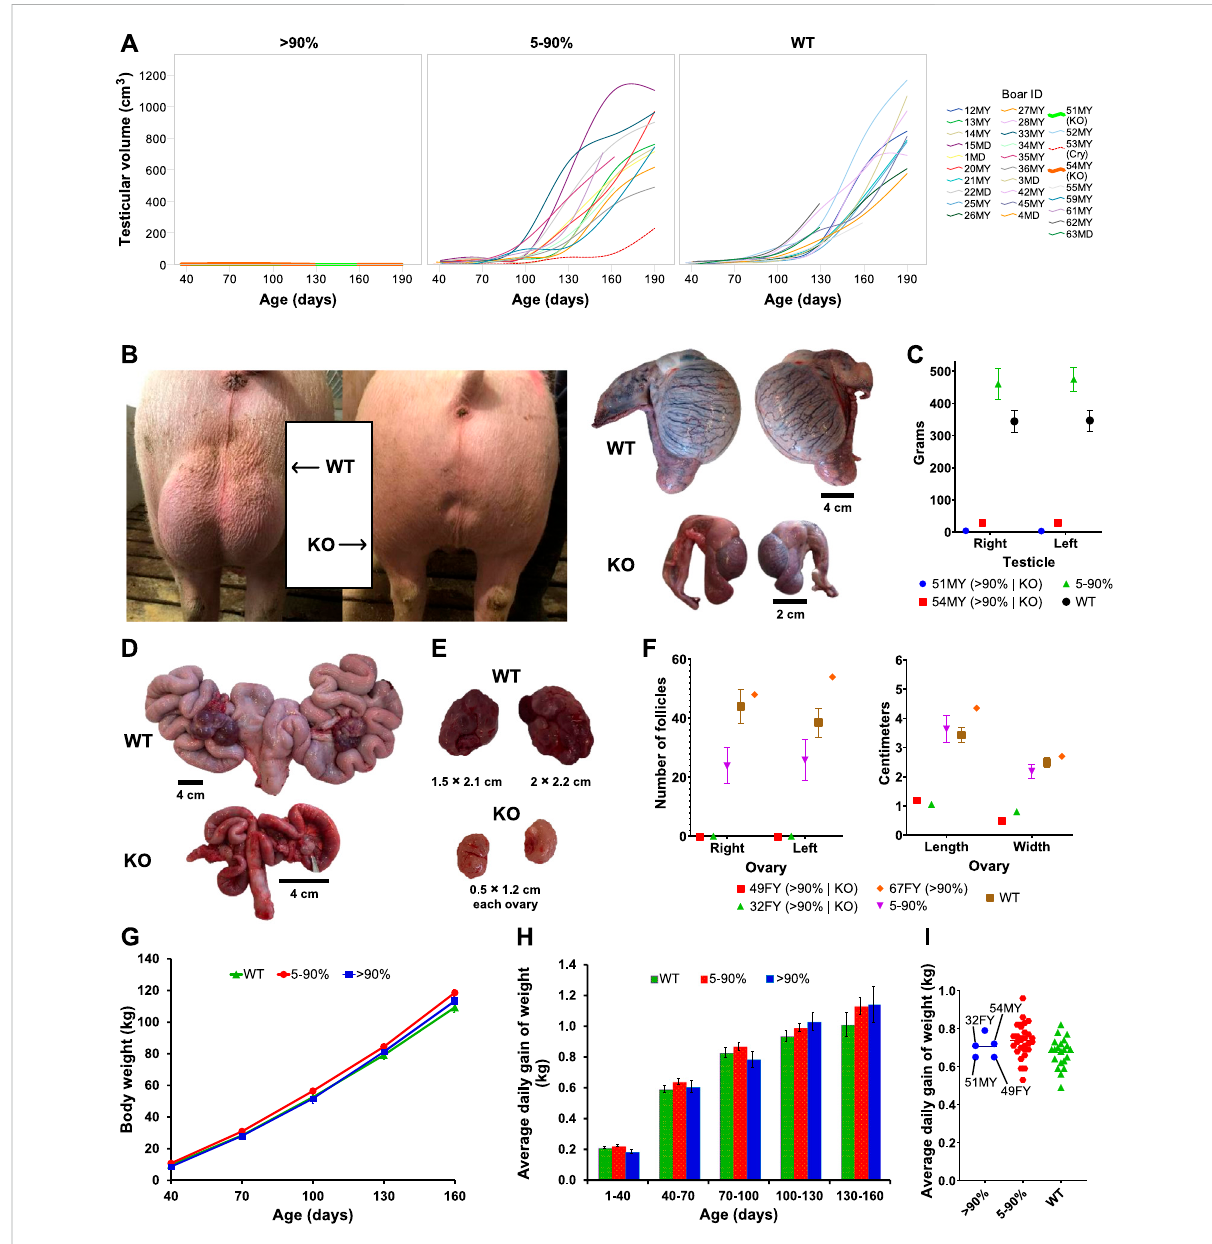
FIGURE 2 Reproductive organ phenotyping and growth-related traits of KISS1 -edited pigs. (A) Representation of individual testicular volumes collected across different time points, where each panel corresponds to a KISS1 -disruption group. “ Cry ” stands for cryptorchid. (B) In vivo and ex vivo comparison ofrepresentativeWT and KISS1 KO testicles. (C) Comparisonofthetesticularweight ofWTand KISS1- edited boars. (D,E) Comparisonof representative WT and KISS1 KO gilt reproductive tracts (D) and ovaries (E) . (F) Follicle countand measurements of ovaries. In (C) and (F) , values are individually represented for pigs with KISS1 -disruptive editing percentages above 90% and as means for the other groups. (G,H) Body weights (LSmeans ± SE; age, p < .001) (G) and average daily gain of weights (LS means ± SE; birth weight, p < .001) (H) across the evaluated time points (±4 days) and periods, respectively. (I) Scatter plot of total average daily gain of weight (i.e., from birth to 160 days of age) with lines indicating the KISS1 KO pigs. In (G – I) , results are grouped by the KISS1 -disruptive editing